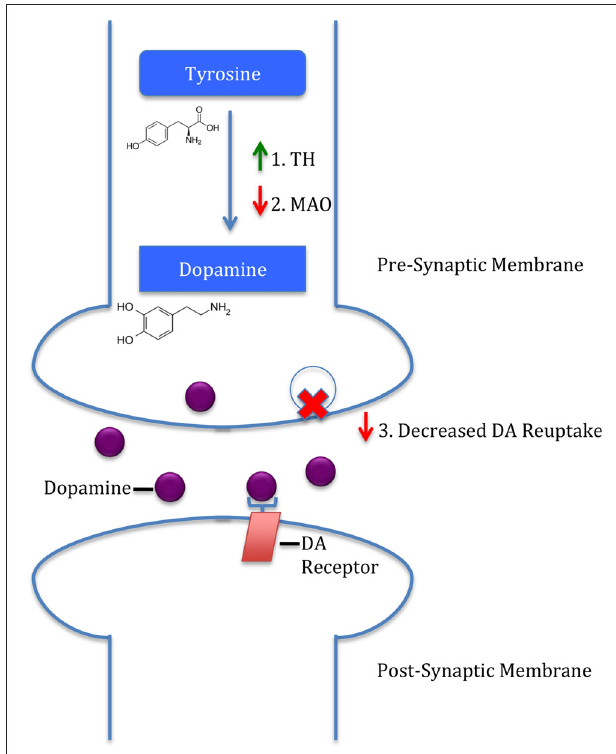
FIGURE 1 | Three mechanisms by which glucocorticoids (GCs) induce dopamine (DA) release. First, GCs upregulate tyrosine hydroxylase (TH), the rate-limiting enzyme in DA synthesis. Second, GCs downregulate monoamine-oxidase (MAO), an enzyme responsible for DA removal. Lastly, GCs are hypothesized to decrease DA reuptake, subsequently increasing synaptic